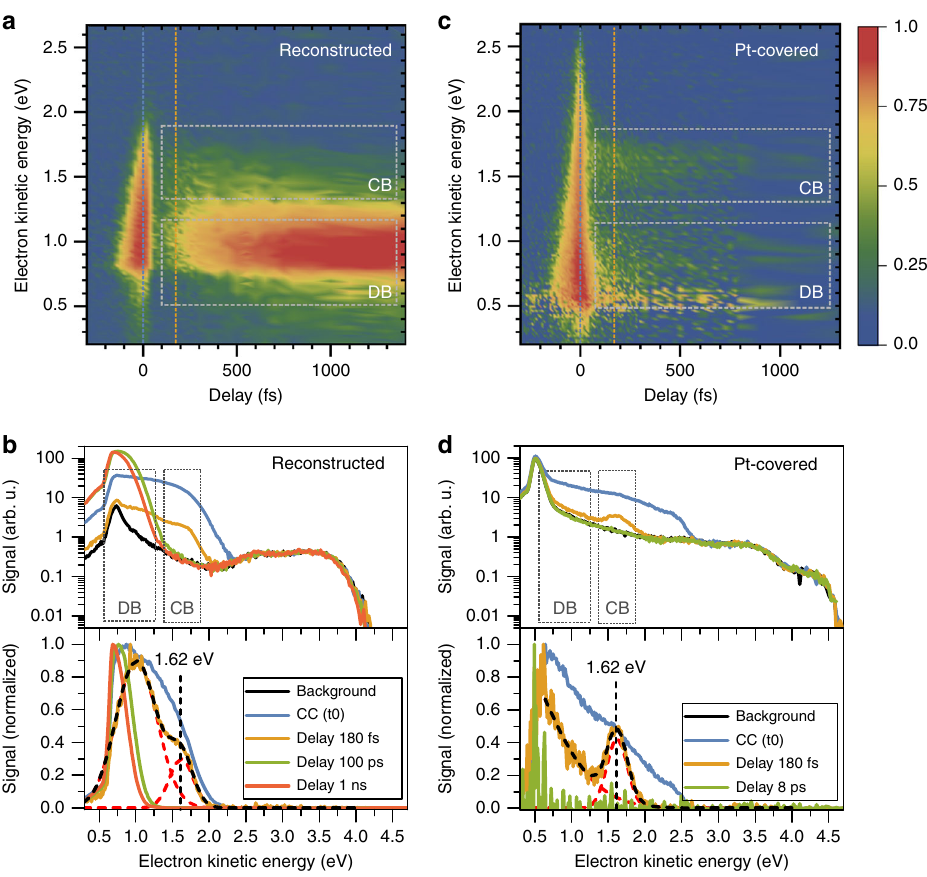
Fig. 2 tr-2PPE spectra. Color maps of the transient photoemission signal as a function of the electron kinetic energy and the pump – probe time delay for the reconstructed Cu 2 O (100) surface ( a ), and for Pt-covered Cu 2 O ( c ). In b and d , selected spectra are shown at the speci fi ed pump – probe delays before (top) and after (bottom) background subtraction. In a – d the positions of the conduction band and defect band are indicated (CC: cross-correlation, DB: defect band, CB: conduction band). Source data are provided as a Source Data fi